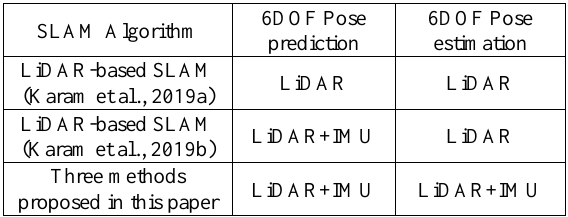
Table 2. Comparison between the proposed methods in this paper and previously developed methods regarding the data source for pose prediction and estimation.